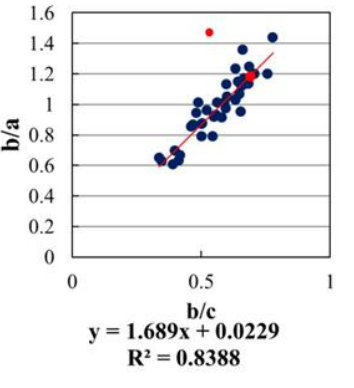
Figure 2. Keyhole and round tomb sizes